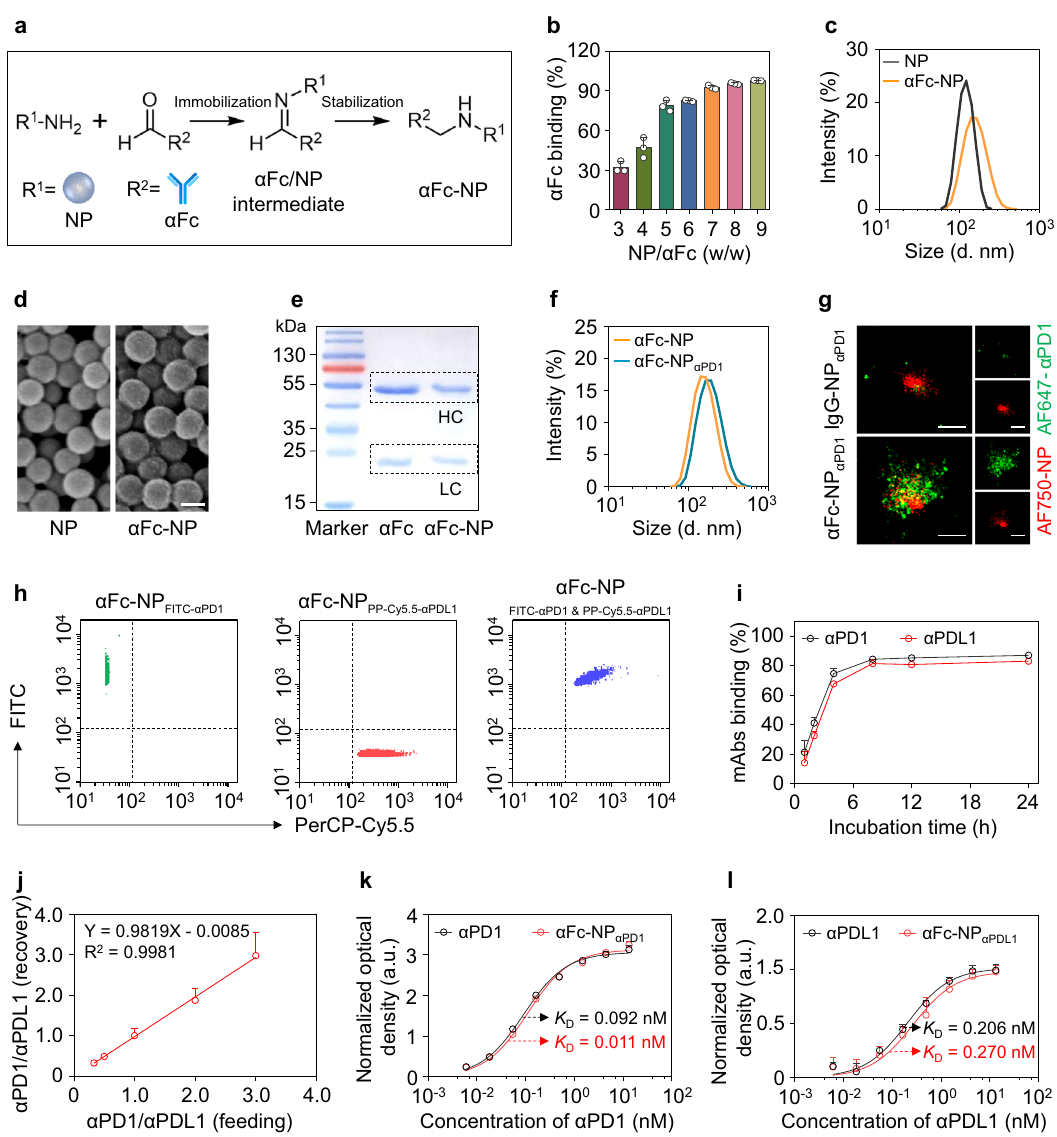
Fig. 2 Construction and characterization of the antibody immobilization platform ( α Fc-NP). a Schematic depicting the construction of α Fc-conjugated nanoparticles ( α Fc-NP). α Fc was oxidized and immobilized onto aminated polystyrene NP via aldol condensation. b Determination of the α Fc binding ef fi cacy by ELISA. c , Average hydrodynamic size of NP and α Fc-NP as determined by DLS, con fi rming that NP had an average diameter of 123.4 ± 4.1 nm and α Fc-NP had an average diameter of 152.8 ± 2.0 nm. d Representative scanning electron microscopy (SEM) image of NP and α Fc-NP. Scale bar, 100 nm. e Reducing SDS-PAGE gel stained with Coomassie Brilliant Blue showing the heavy chain (HC) and light chain (LC) released from soluble α Fc or α Fc-NP. β - mercaptoethanol treatment breaks the interchain disul fi de bonds and separates HC and LC of α Fc. The molecular weights of HC and LC are approximately 50 kDa and 25 kDa, respectively. f Size distribution of α Fc-NP and α Fc-NP α PD1 determined by DLS, con fi rming the α Fc-NP α PD1 had an average diameter of 176.1 ± 5.3 nm, 30 nm larger than α Fc-NP. g Stochastic optical reconstruction microscopy (STORM) images of IgG-NP α PD1 and α Fc-NP α PD1 . NP and α PD1 were labeled with AF750 and AF647, respectively. An NP conjugating IgG control antibody (IgG-NP) was used as a control. Scale bar, 200 nm. h Nano fl ow Cytometry showed that α Fc-NP could simultaneously bind two types of mAbs. α Fc-NP was incubated with FITC-labeled α PD1 and PerCP-Cy5.5-labeled α PDL1 separately or in combination. i Binding ef fi cacies of α PD1 and α PDL1 versus incubation time. α Fc-NP were incubated with α PD1 and α PD1 at an α Fc: α PD1: α PDL1 ratio of 1:0.5:0.5 for different periods, and then the unbound α PD1 and α PD1 were then examined by ELISA. j The ratio of α PD1 and α PDL1 immobilized by α Fc-NP. α Fc-NP was incubated with α PD1 and α PDL1 at an α Fc: ( α PD1 & α PDL1) ratio of 1:1, while the ratio of α PD1 and α PDL1 ranged from 0.3 to 3.0. k , l The capabilities of α Fc-NP α PD1 and α Fc-NP α PDL1 to bind corresponding antigens. Data are the means ± s.d of three different experiments with similar results. Source data are provided as a Source Data fi